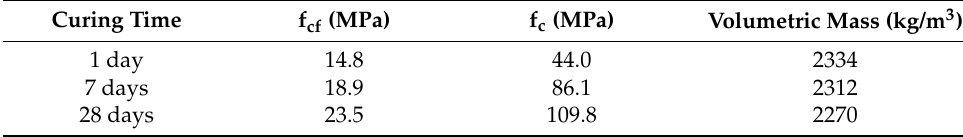
Table 6. Properties of UHPSFRC, mixture C.